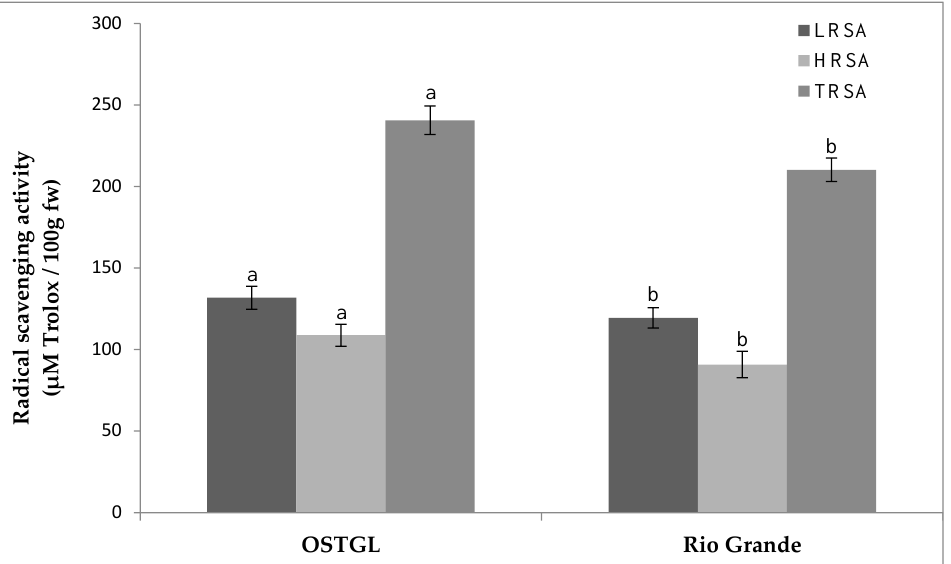
Figure 1. Lipophilic (LRSA), hydrophilic (HRSA), and total (TRSA) radical scavenging activities of the different tomato varieties grown organically. Data are mean ± S.E. of four replicates. Different letters indicate a significant difference with the LSD test ( p < 0.05).